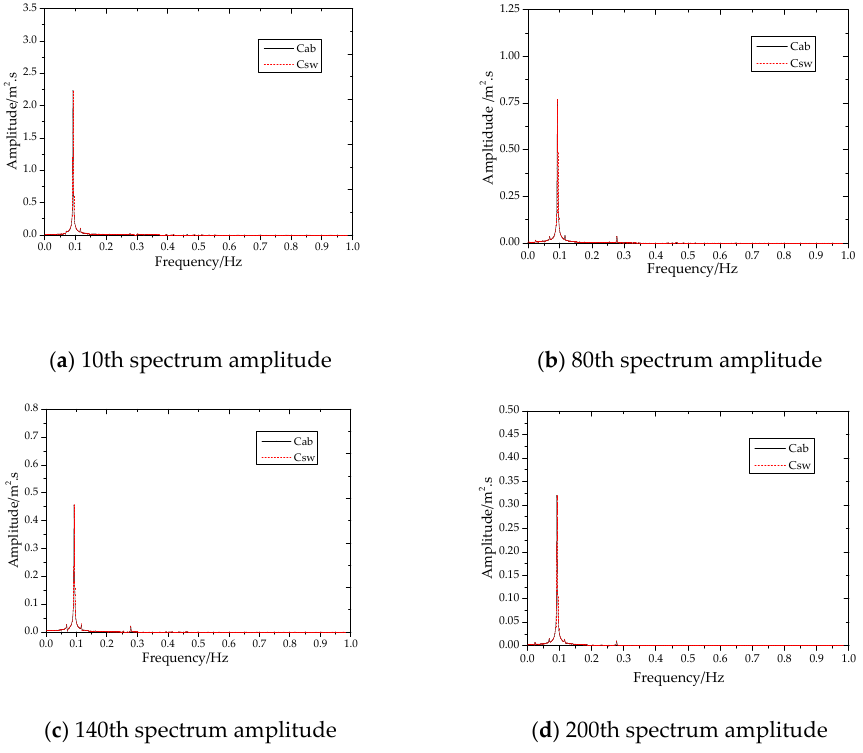
Figure 17. 10th–200th spectrum amplitude of condition 1. Table 14. Main frequency and reduction of with/no rigid body swing along water